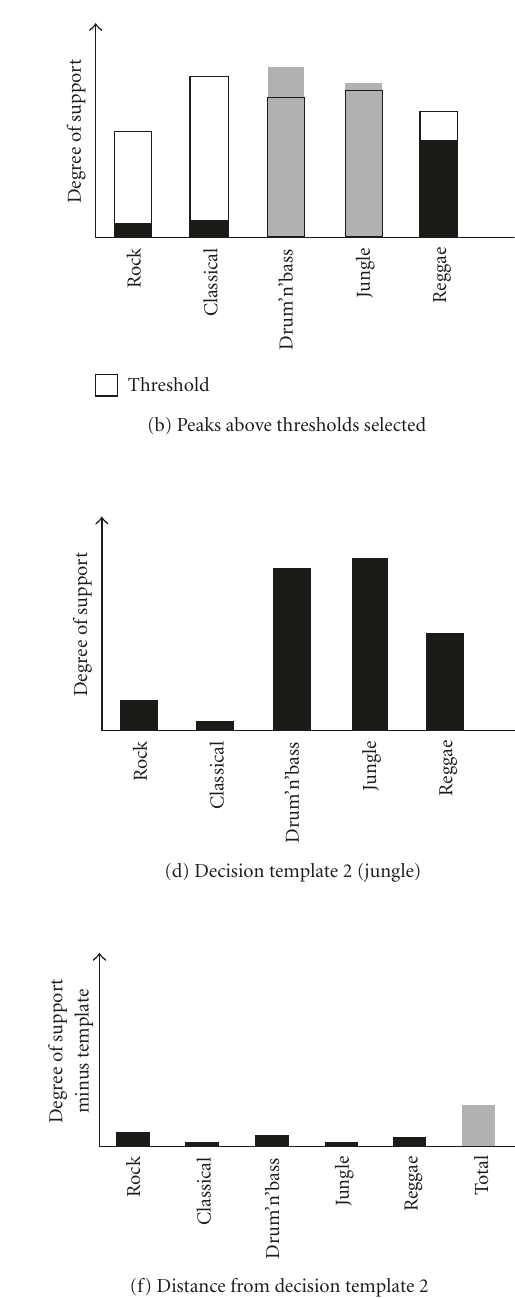
Figure 1: Selecting an output label from continuous degrees of